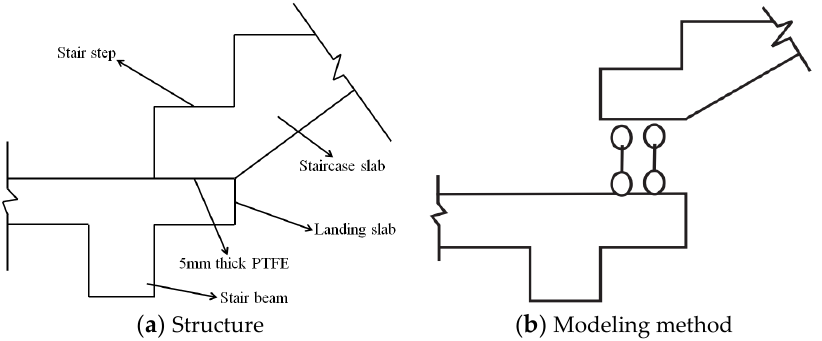
Figure 1. Structure and modeling method of the sliding bearing.